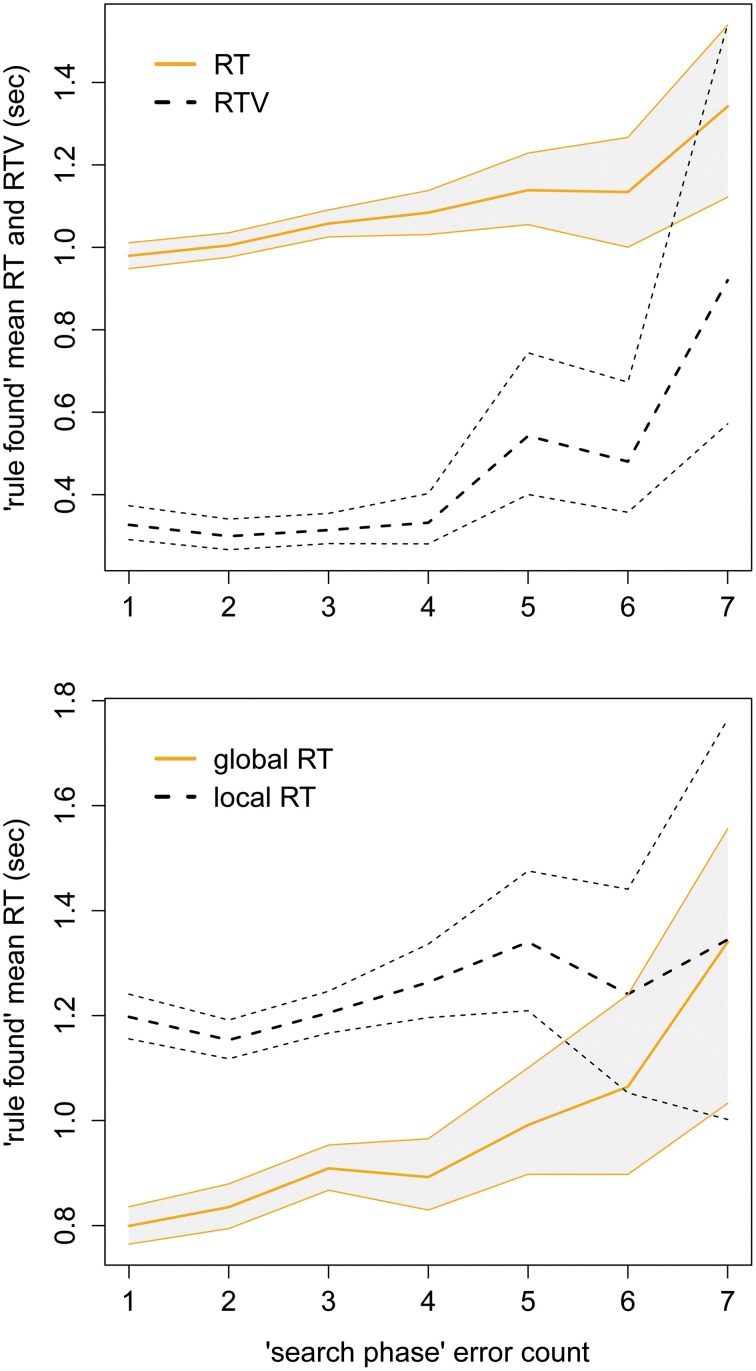
Top panel: mean RT, and RTV, of correct trials when the rule is found, plotted against errors during search, with bootstrapped 95% CI. Lower panel: mean RTs, abscissa and ordinate as top panel, split by global or local search focus.